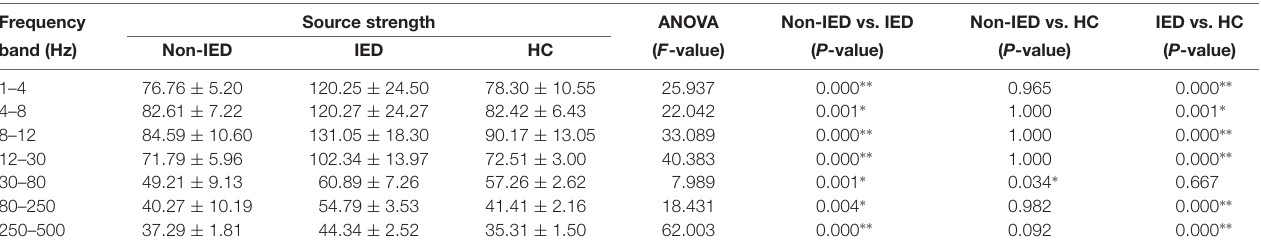
TABLE 3 | Analysis of neuromagnetic source strength between IED, non-IED and HC group. Frequency Source strength ANOVA Non-IED vs. IED Non-IED vs. HC IED vs.